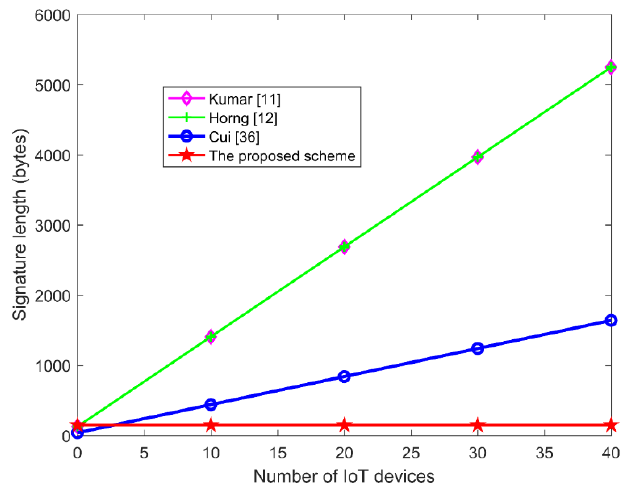
Figure 6. The comparison of signature length in IoTs.